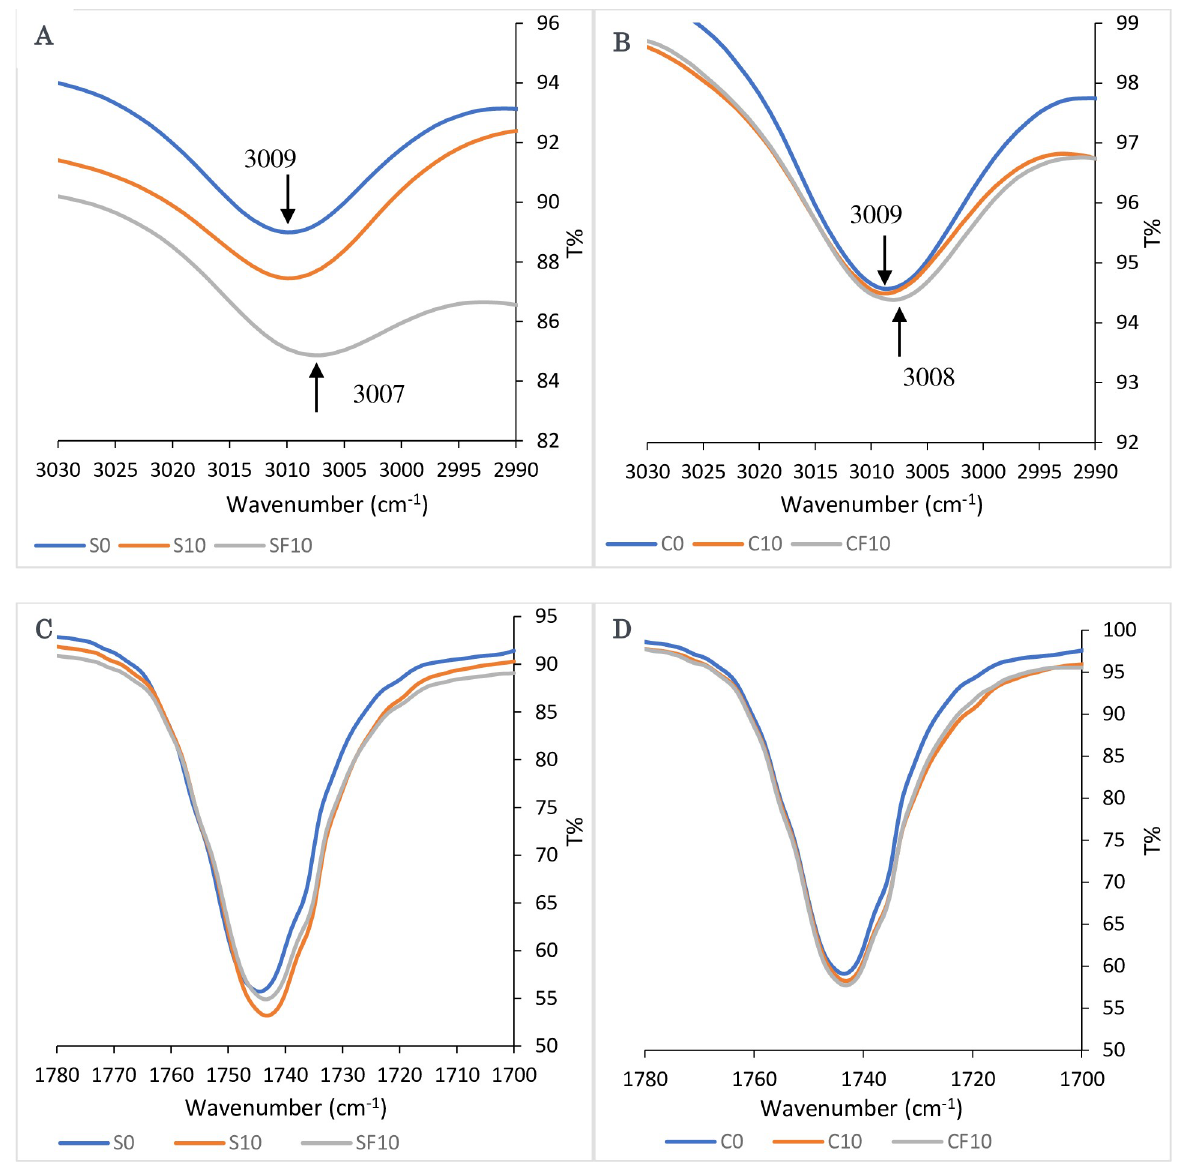
Fig 6. FTIR spectra of the 3006 cm − 1 band shifts of (a) sunflower oil samples, (b) corn oil samples in response to heating and frying and the changes in the C = O region of infrared spectra for (c) sunflower oil samples, (d) corn oil samples.